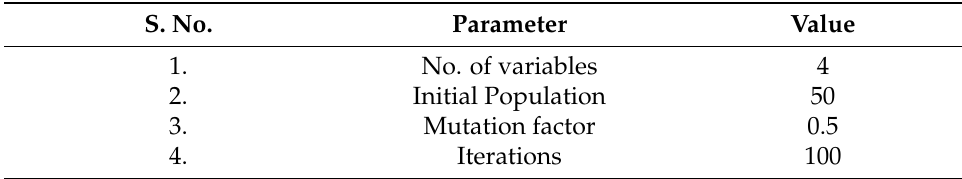
Table 4. Parameters of DE